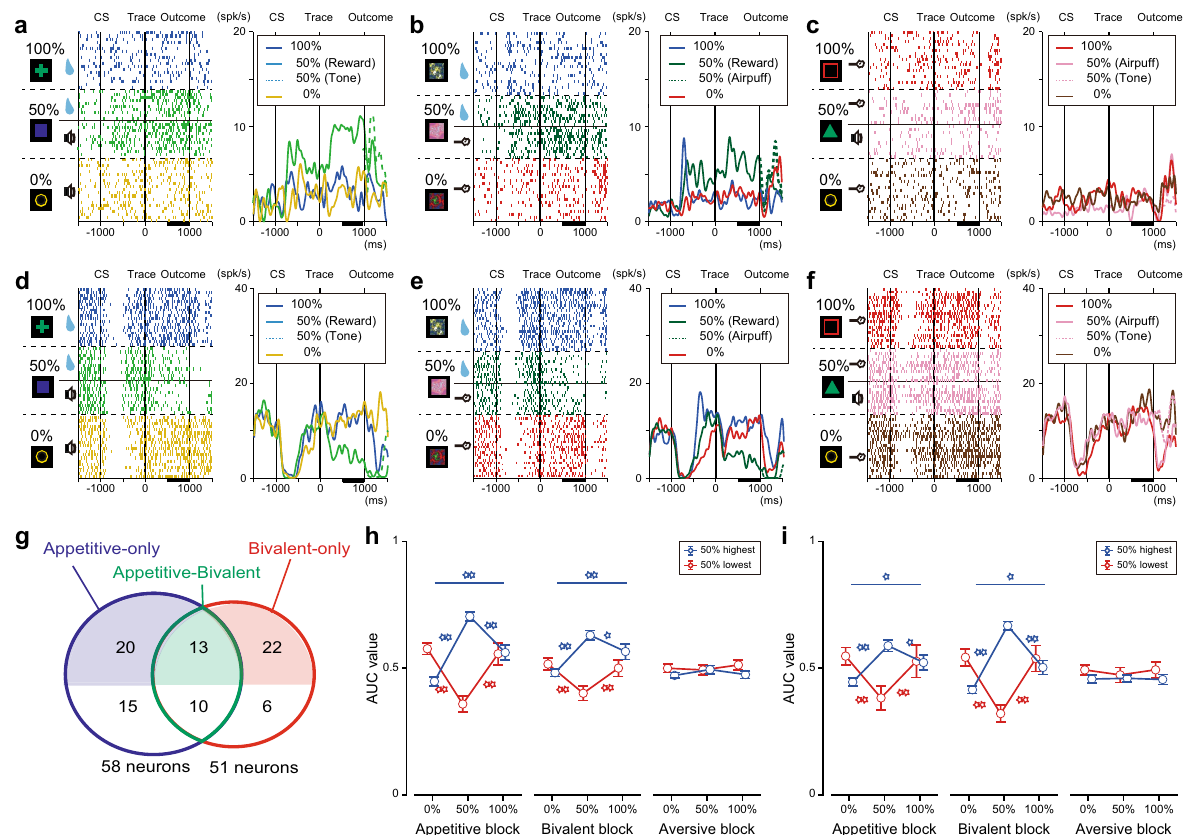
Figure 4. Responses of uncertainty-coding neurons in the lateral hypothalamus. ( a–f ) Representative responses of a 50%-highest neuron in the appetitive ( a ), bivalent ( b ), and aversive ( c ) blocks in the rasters ( left ) and histograms ( right ) and a 50%-lowest neuron in the appetitive ( d ), bivalent ( e ), and aversive ( f ) blocks. CS, conditioned stimulus. ( g ) Number of uncertainty-coding neurons in the appetitive and bivalent blocks (appetitive-only type: blue; bivalent-only type: red; appetitive-bivalent type: green). ( h–i ) Preferred response modulation of the 50%-highest and 50%-lowest neurons that were defined by their activity in the appetitive ( h ) and bivalent ( i ) blocks. Response modulation was assessed by the activity during the last 500 ms of the trace period relative to that during the last 500 ms before TC onset. * p < 0.05/3, ** p < 0.01/3, Wilcoxon rank-sum test with Bonferroni’s